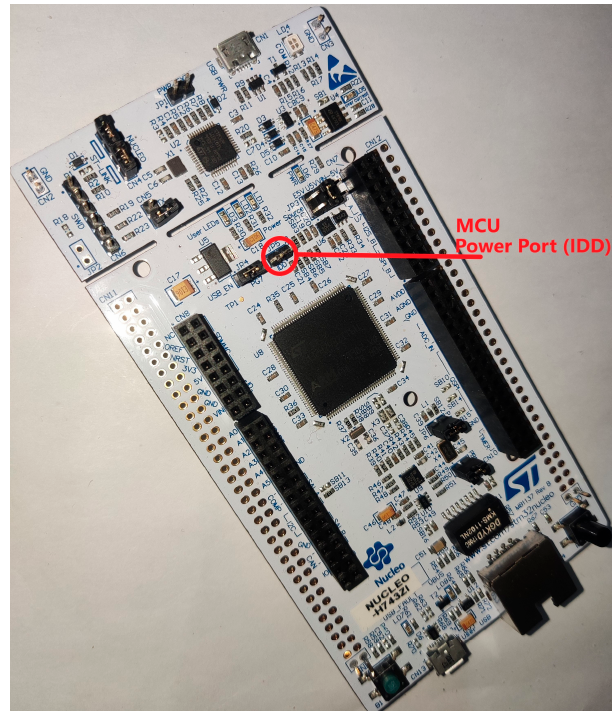
Figure 4. STM32H743-Nucleo Development Board.